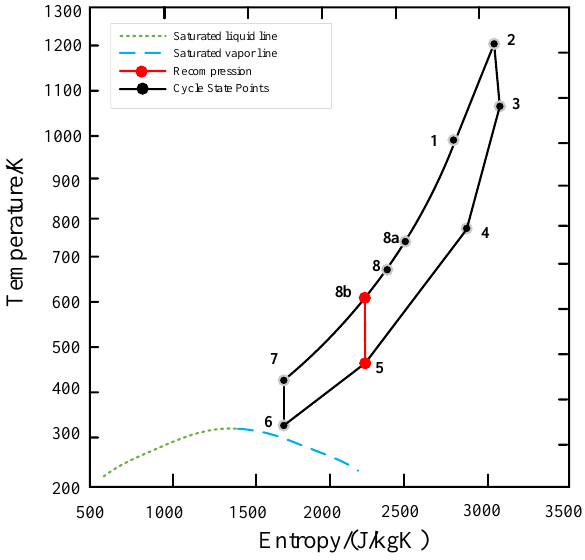
Figure 4. T-s diagram representation for the proposed S-(N 2 O-He) cycle [13].